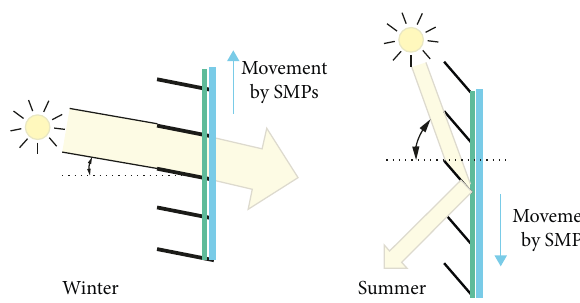
Figure 7: Schematic diagram of thermally responsive SMPs in heat controls of window